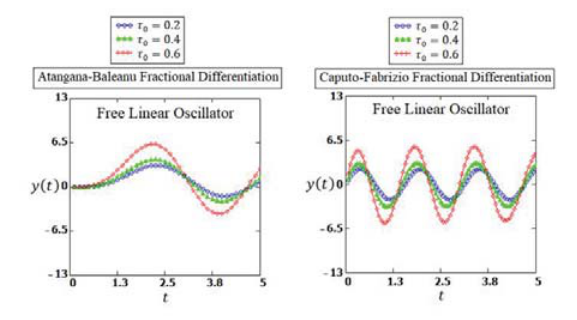
Figure 1: Profile of displacement for varying damping ratio response curves with parametric values F = 0, ω = 1.2, t = 2 s , η 1 = η 2 = 0.7 subject to Atangana-Baleanu and Caputo-Fabrizio fractional differential operators.